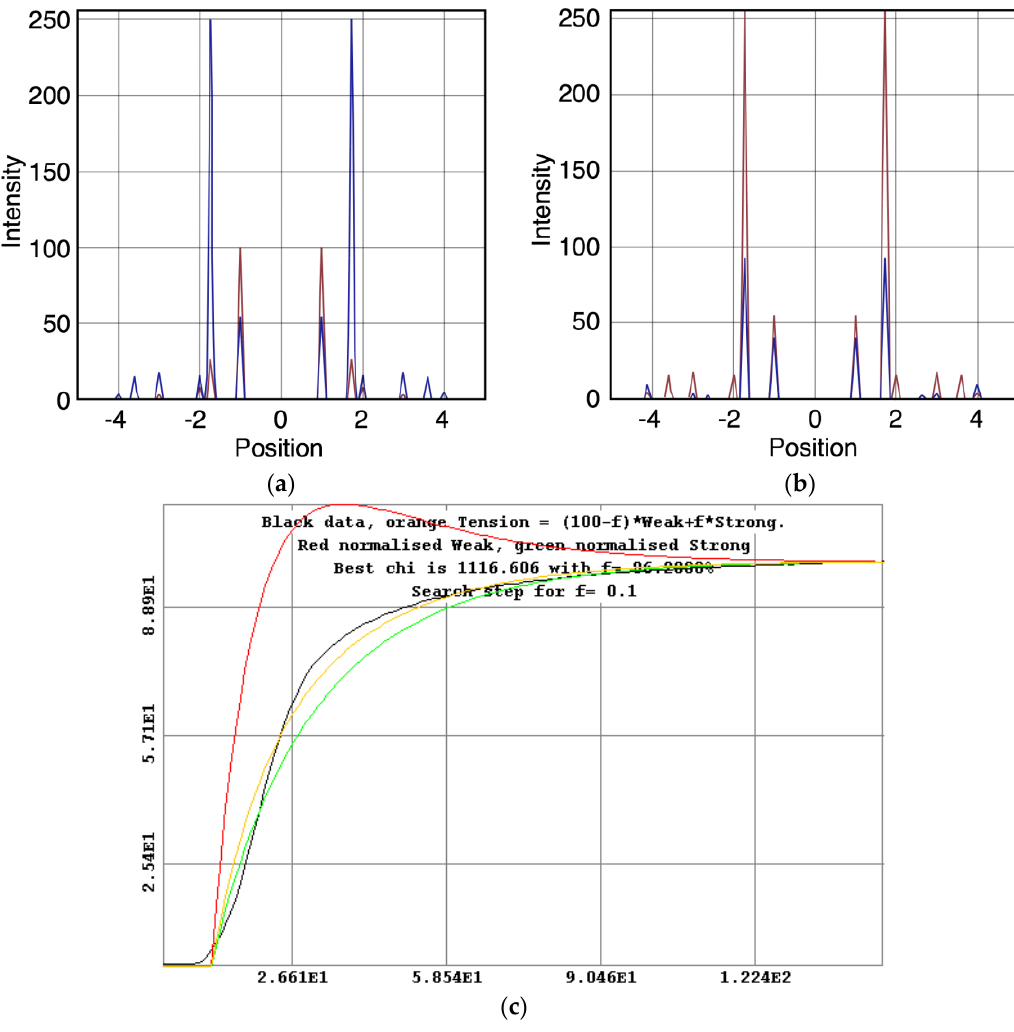
Figure 10. Plots of the best modelled X-ray amplitudes, tension and state populations for the 3-state model (C in Figure 2b) shown in Figure 9. ( a ) Modelled X-ray amplitudes for the off state, in red, and the weak state, in blue. ( b ) Modelled X-ray amplitudes for the weak state, in red and the rigor-like state, in blue. ( c ) Plot of the tension calculation for the 3-state model including rigor in which a percentage f is in the strong state and a percentage (100 − f ) is in the weak state. The experimentally measured tension is shown in black, the fitted tension in orange and the noramlised populations in the weak and rigor-like states in red and green respectively. The fitting gives most heads in the rigor state ( f = 96%).